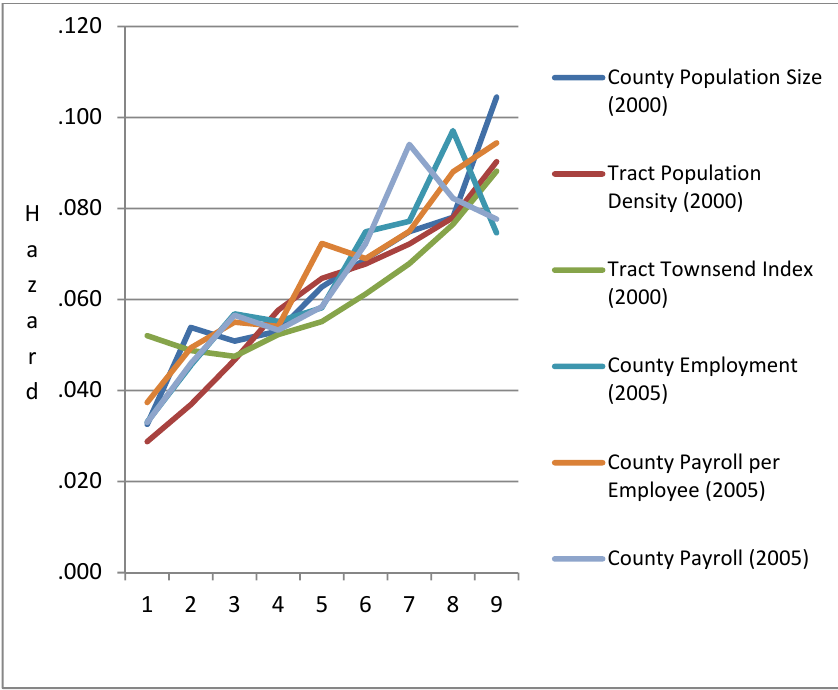
Figure A1. Gradients in HAP Neurological Health Exposure Hazard (2005) at Progressive Deciles of Population Size, Density, Economic Activity, and Socioeconomic